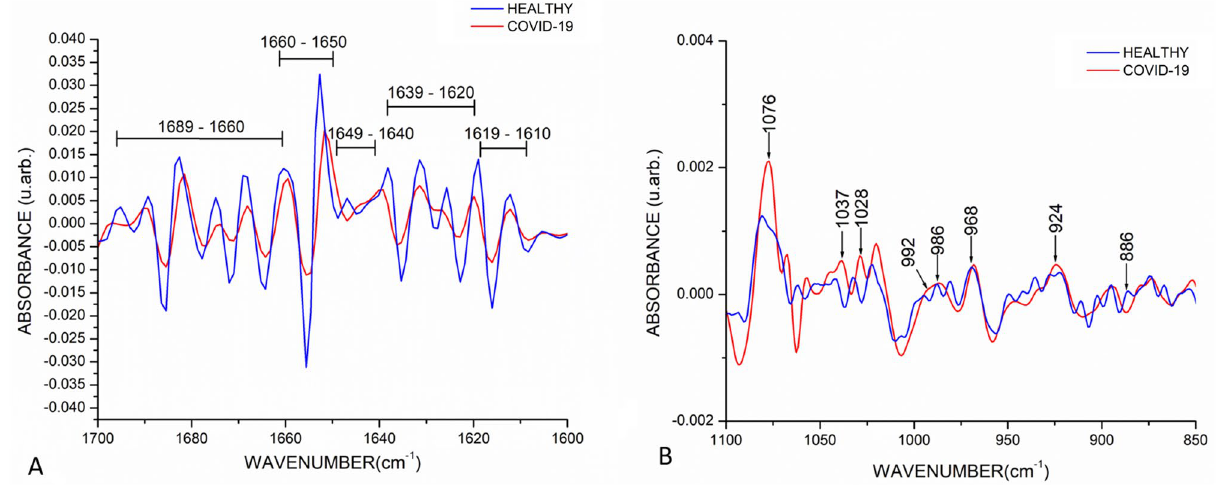
Figure 2. Mean of FTIR second derivative spectra of healthy (N = 1209) and COVID-19 (N = 255) groups. ( A ) Amide I region (1700–1600 cm −1 ), bands related to the components of the secondary structure of proteins are shown, such as β-turns (1695–1660 cm −1 ), α-helices (1660–1650 cm −1 ), intramolecular native β-sheets (1640– 1630 cm −1 ), and intermolecular β-sheets (1625–1615); herein an increment in the intensity of these bands in the healthy group compared with the COVID-19 group is observed. ( B ) Nucleic acids region (1100–850 cm −1 ), bands corresponding to symmetrical stretching vibrations of PO 2 phosphodiester groups (1076 cm −1 ), glycogen (1037 cm −1 and 1028 cm −1 ), stretching vibration C–C of DNA backbone (968 cm −1 ), and vibration of ribose ring (924 cm −1 ) showed an increment in the intensity in the COVID-19 group. Moreover, the bands related to the ribose phosphate main chain (992 cm −1 ) and stretching vibration C–C of DNA backbone (986 cm −1 ) exhibited a change in their conformation in the COVID-19